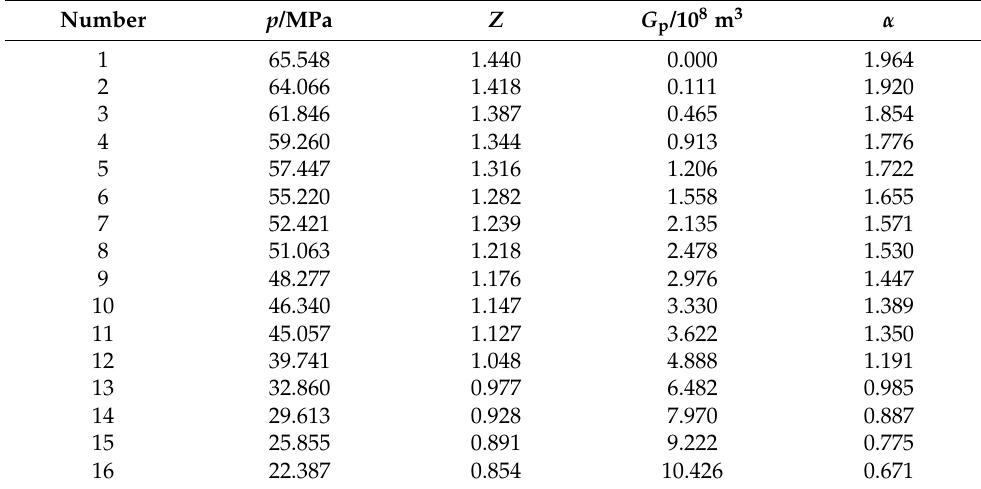
Table 3. Historical production data of the Anderson L gas